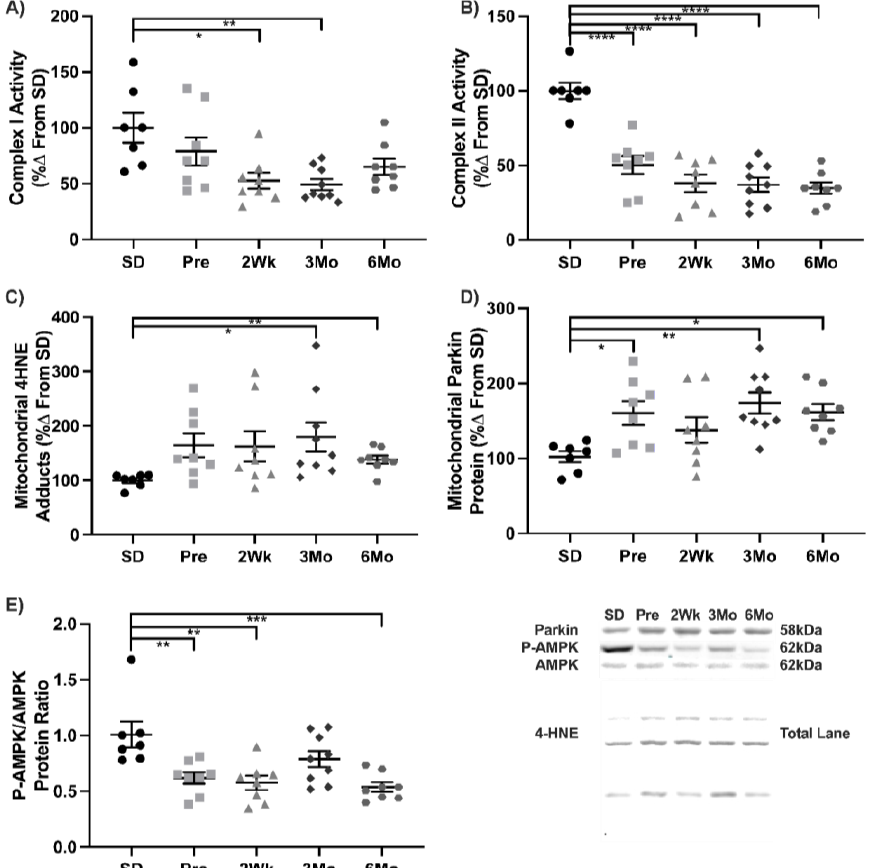
Figure 5. Mitochondria dysfunction and oxidative damage increase as T2DM progresses. Mean ± SEM values of ( A ) Complex I activity, ( B ) Complex II activity, ( C ) mitochondrial 4HNE adducts, ( D ) mitochondrial Parkin protein, and ( E ) ratio of phosphorylated (T172) to native AMPK protein in Sprague-Dawley (SD; n = 7), pre-diabetic UCD-T2DM (Pre; n = 9), 2-week diabetic UCD (2Wk; n = 9), 3-month diabetic UCD-T2DM (3Mo; n = 13), and 6-month diabetic UCD-T2DM (6Mo; n = 9) rats. * p < 0.05, ** p < 0.01, *** p < 0.001, **** p <